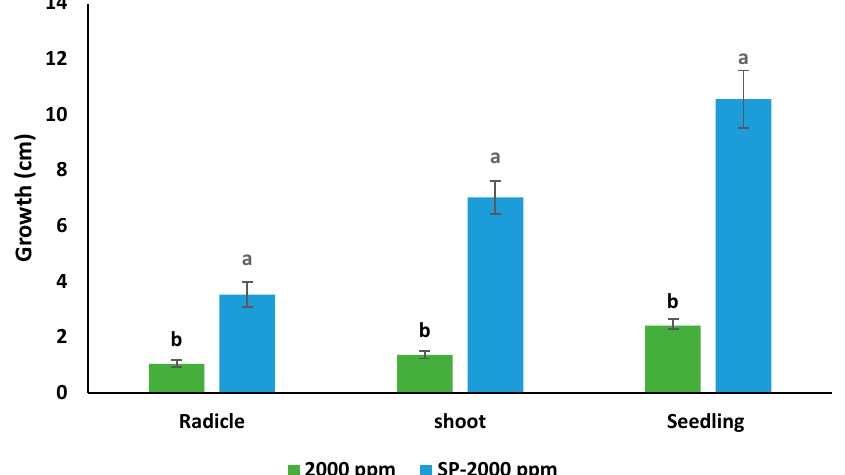
Figure 10. Responses of radicle, plumule, and seedling to two methods of fungicide control (sterilization SP-2000 ppm and growth media 2000 ppm). Means are presented ± SD ( n = 100). At p < 0.05, values labeled with different letters differ significantly. They began in order, with the letter (a) being the most significant.